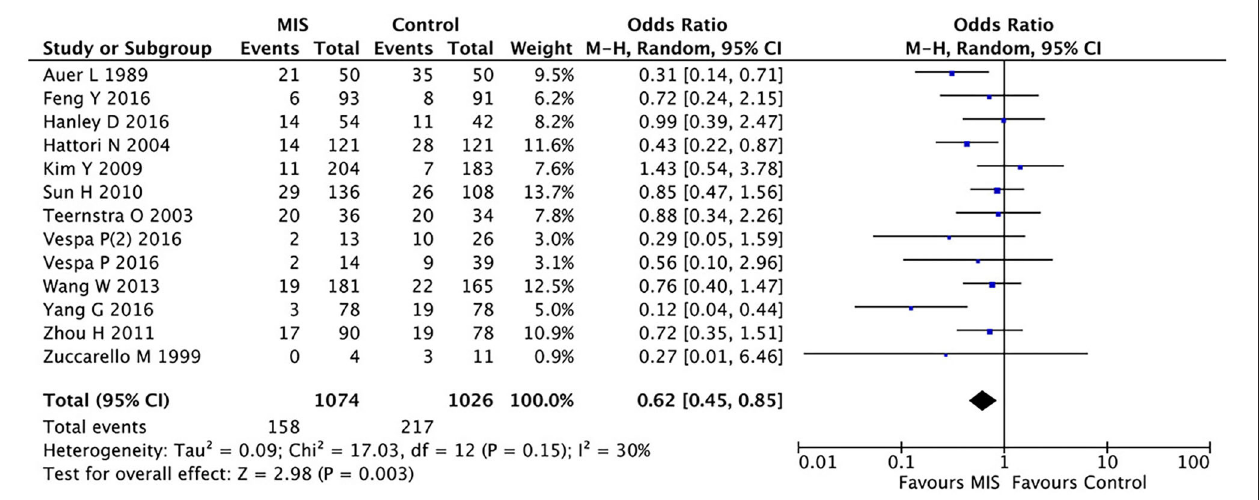
FIGURE 2 | A forest plot of the minimally invasive surgery and control groups for overall mortality.